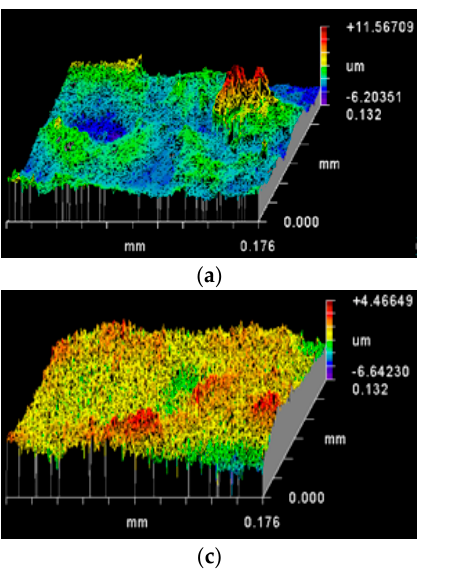
The surface map (Figure 3a) and the SEM image (Figure 1a) show that the flattened native Ag wires have an inherently rough topography with plateaus (green and yellow colours), troughs (blue colour indicating valleys) and irregular features (red colour indicating peaks/summits). The roughness of flattened native Ag wires was in the microscale with an R t value of 11.15 ± 0.89 µm and an R a of 0.95 ± 0.10 µm. The R a lesser than 1 and the more green colour compared to yellow in the surface topography maps could indicate that the mean linear surface of the Ag wires is skewed towards the valleys (more average valleys compared to the average peaks across the surface profile) (Figure 1c and Table 1). However, a 32.20% higher R q value compared to its corresponding R a indicates that there are more high peaks and deep valleys deviating from mean linear surface of the Ag wires (Table 1) leading to an overall rougher surface.